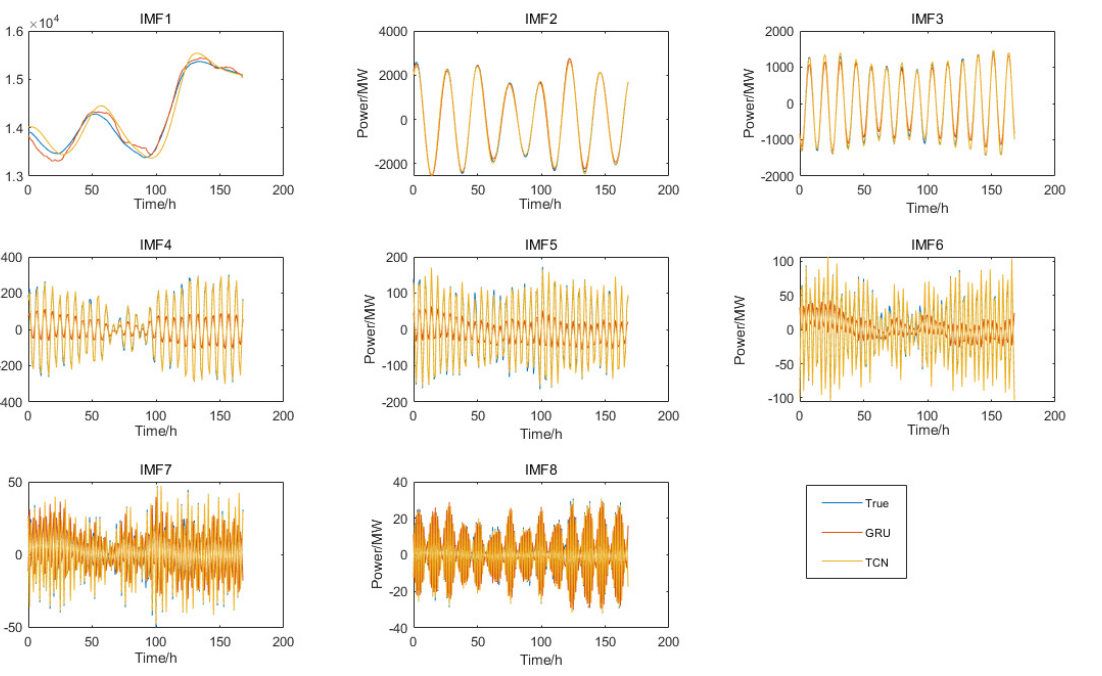
Figure 8. The forecasting results of GRU and TCN, respectively, in the high-frequency component.